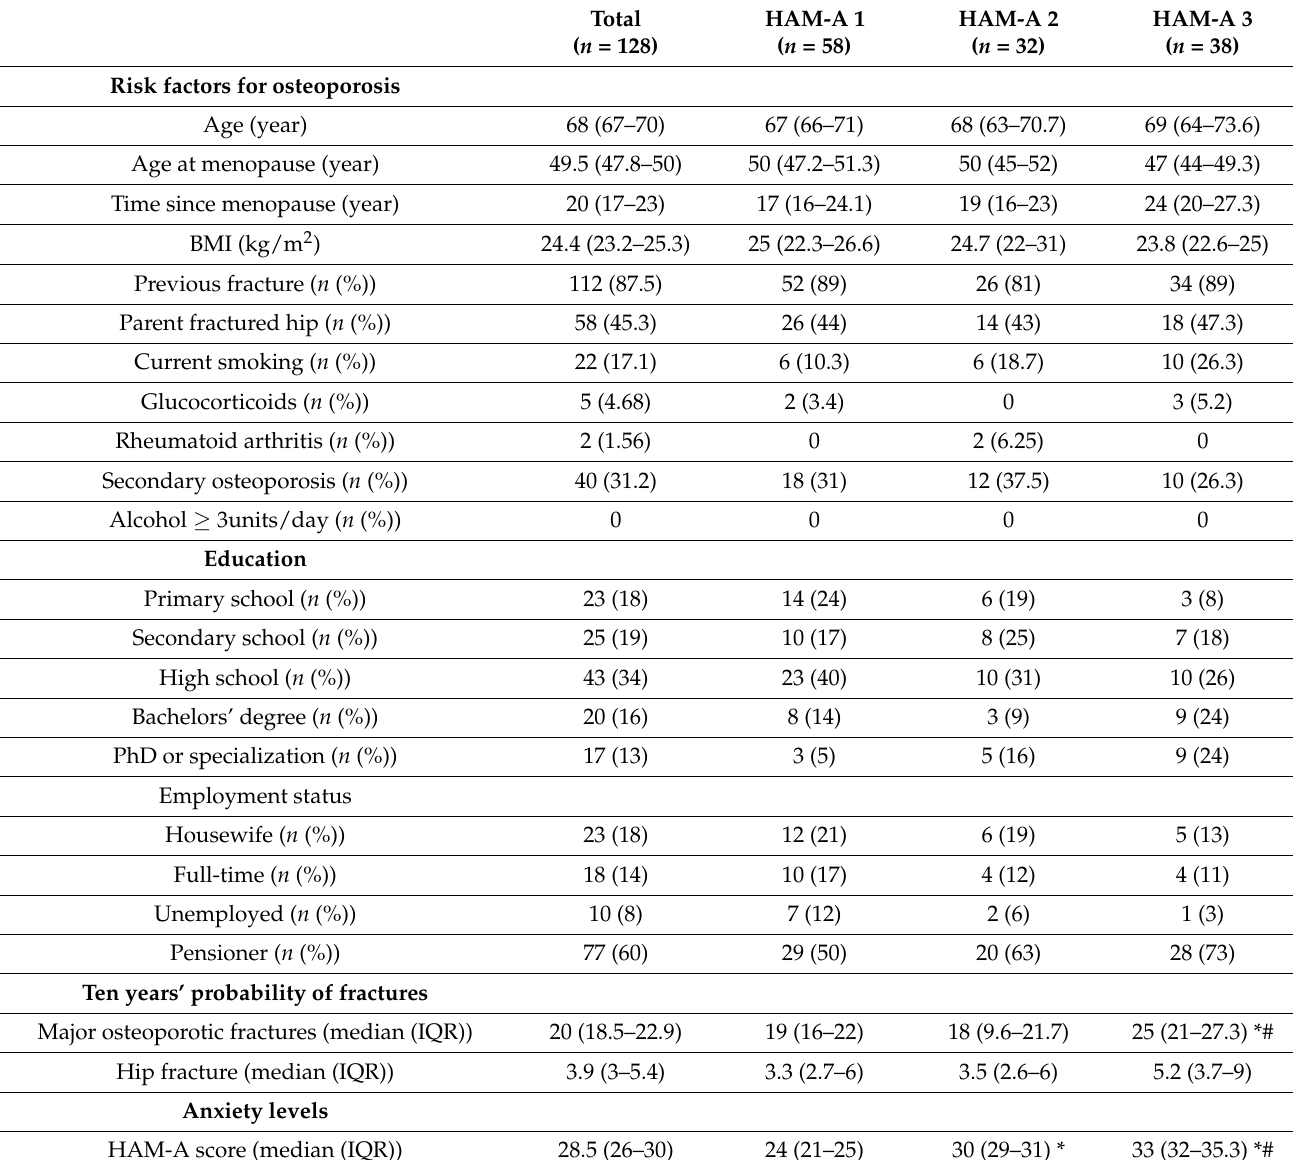
Table 1. Main clinical characteristics of recruited postmenopausal women receiving prescription of weekly alendronate or risedronate as anti-osteoporotic medical